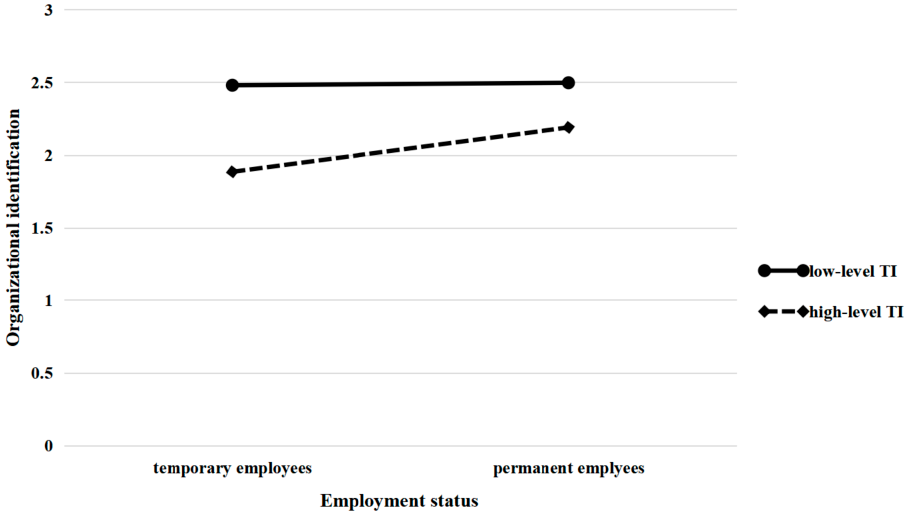
Figure 2. Interaction between employment status and turnover intention on organization identifi- cation.